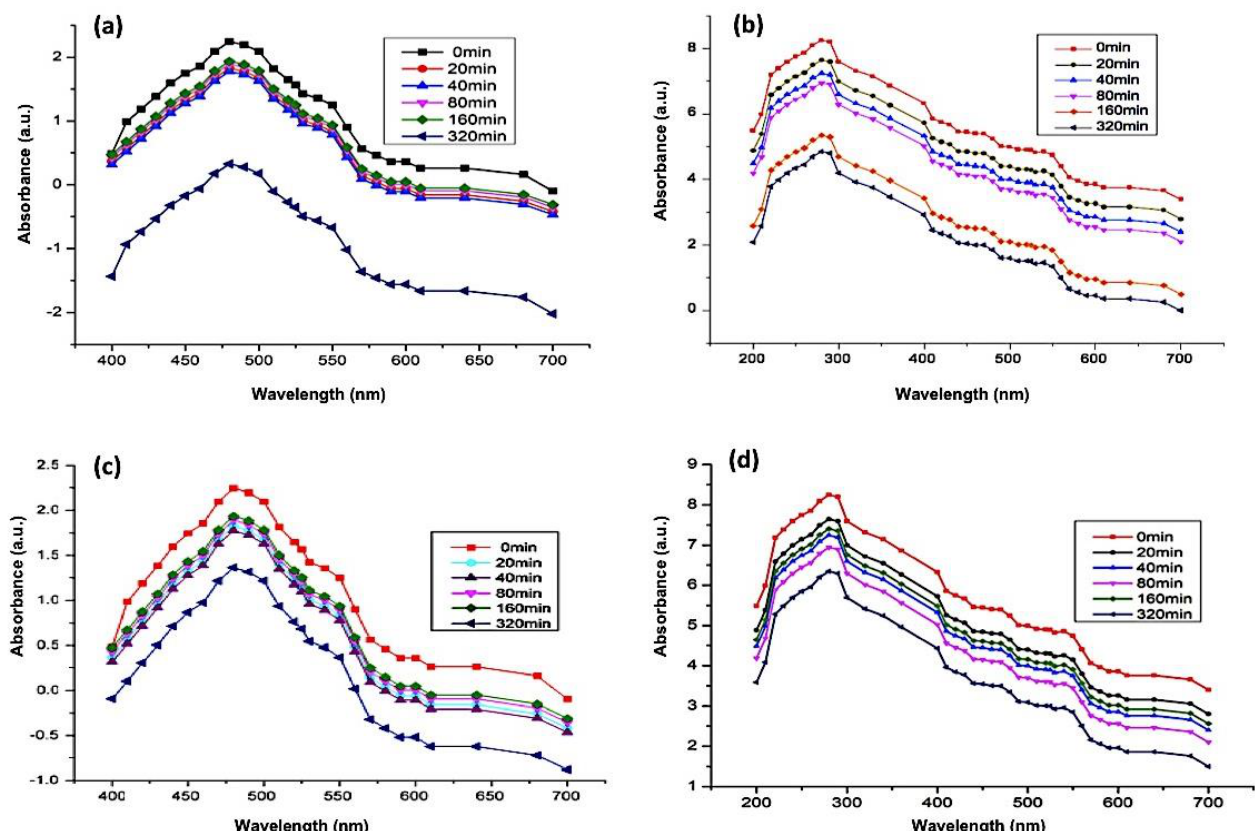
Figure 7. Absorption spectrum of ( a ) DOX-encapsulated ZnO-nanoparticles (DOX-ZnO-NPs), ( b ) GEM-encapsulated ZnO-nanoparticles (GEM-ZnO-NPs), ( c ) doxorubicin-encapsulated PEGylated nanoparticles (DOX-PEG-ZnO-NPs), and ( d ) GEM-encapsulated PEGylated nanoparticles (DOX-GEM-ZnO-PEGNPs (GEM-PEG-ZnO-NPs).